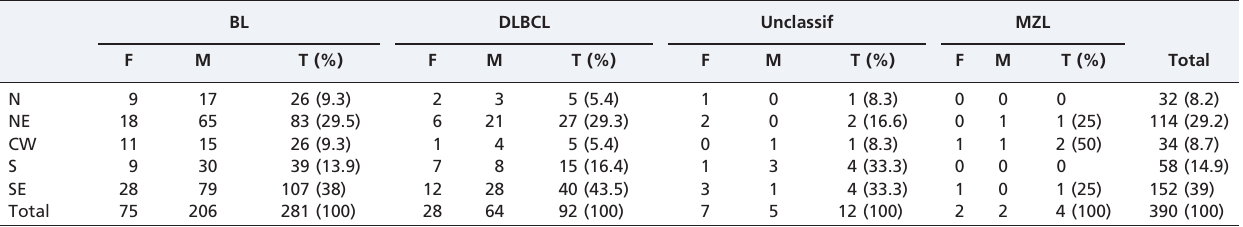
Table 4 - Mature B-cell lymphoma in pediatric patients, distribution by gender and geographical areas for each subtype BL DLBCL Unclassif